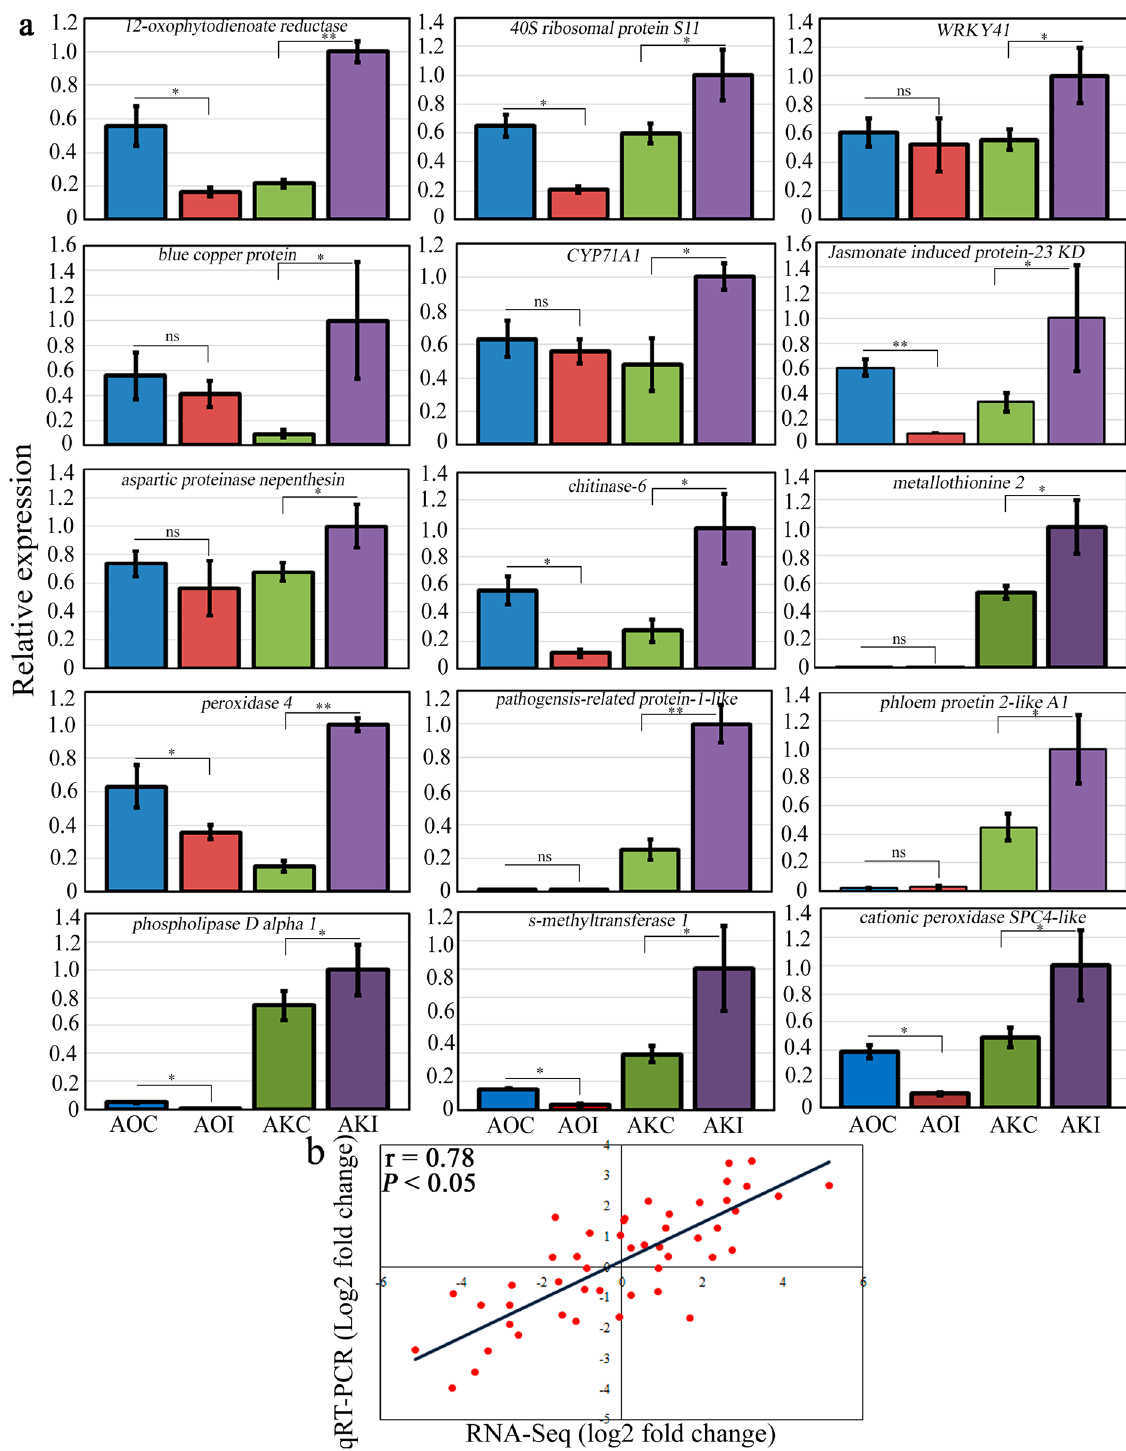
Figure. 6. Validation of RNA-Seq data with quantitative real-time reverse transcription PCR (qRT-PCR). ( a ) Bar plot of qRT-PCR relative expression in Asparagus kiusianus and A . officinalis treated with distilled water (AKC and AOC, respectively) and inoculated with Phomopsis asparagi (AKI and AOI, respectively). ( b ) Scatter plot correlation between qRT-PCR and RNA-Seq log2 fold changes (Pearson’s correlation coefficient = 0.78). Values represent the mean on three independent biological replicates (n = 3) ± standard deviation (SD). Significance levels are given as: * ( P < 0.05) and ** ( P < 0.01) and according to analysis of variance